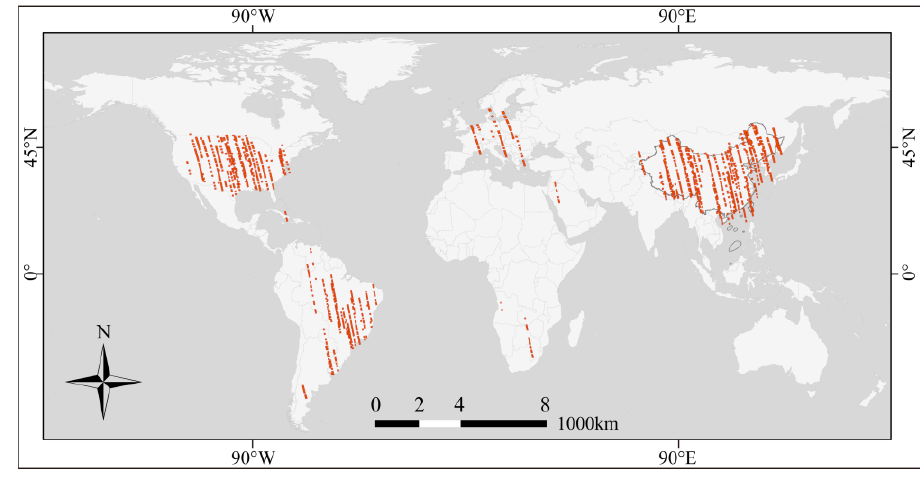
Figure 6. Distribution of Gaofen-5 (GF-5) satellite imagery.